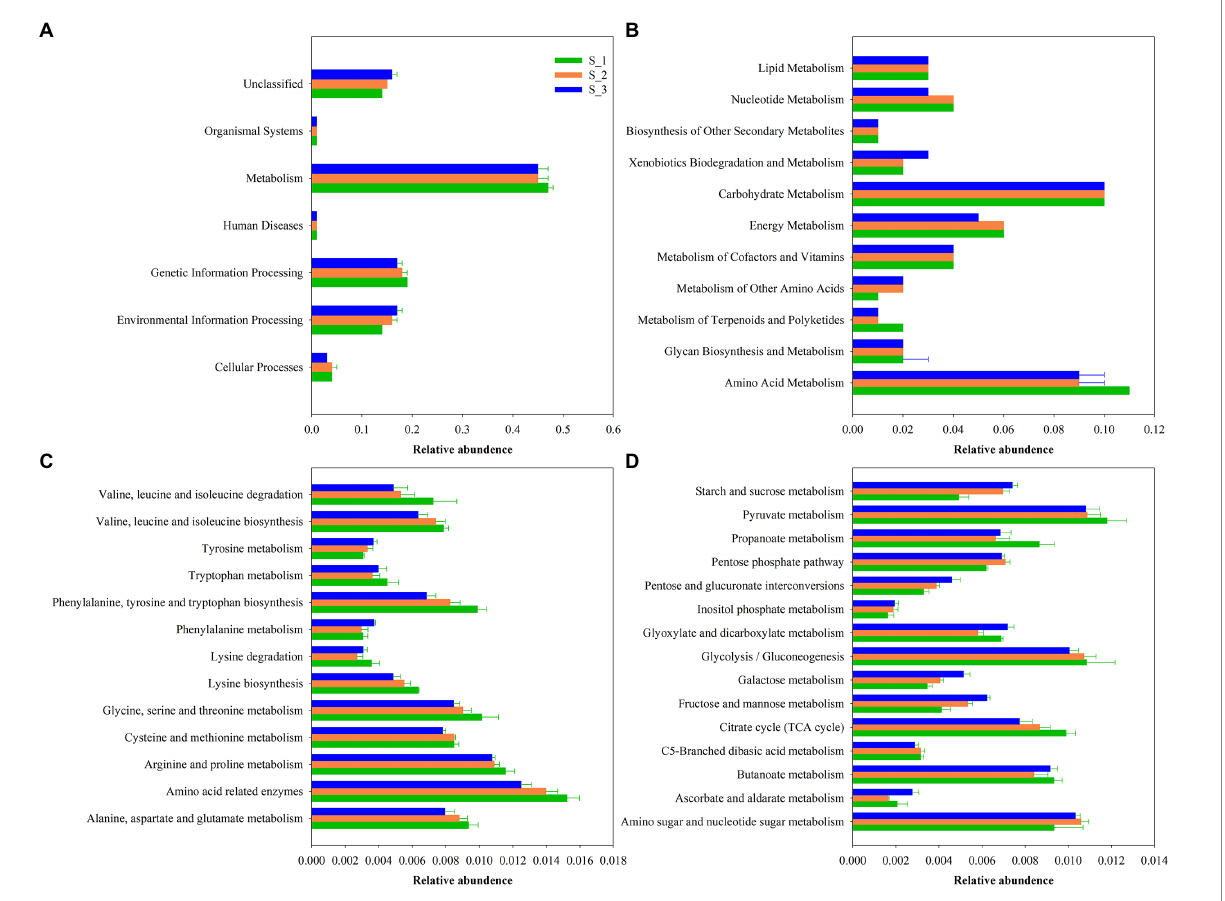
FIGURE 8 Bar graphs showing 16S rRNA gene-predicted functional profiles on the first (A) , second (B) pathway level, amino acid metabolism, (C) and carbohydrate metabolism (D) of the third pathway level obtained with Tax4Fun. S_1, ensiled alfalfa in the first cutting, S_2, ensiled alfalfa in the second cutting, S_3, ensiled alfalfa in the third cutting. The green filled bar indicate S_1, the orange filled bar indicate S_2, the blue filled bar indicate